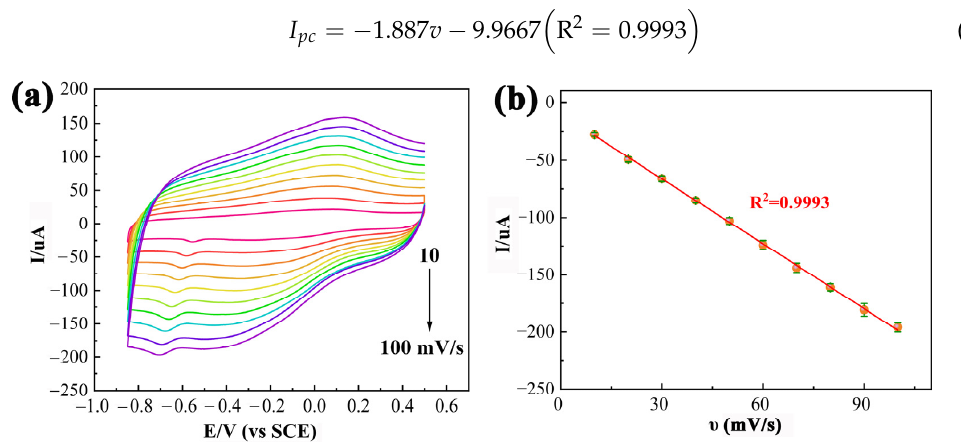
Figure 8. ( a ) CVs of PDPP/GO/GCE in 0.1 M PBS containing 0.01 mM CAP at various scan rates (10–100 mV/s), ( b ) the plots of peak current vs. υ .